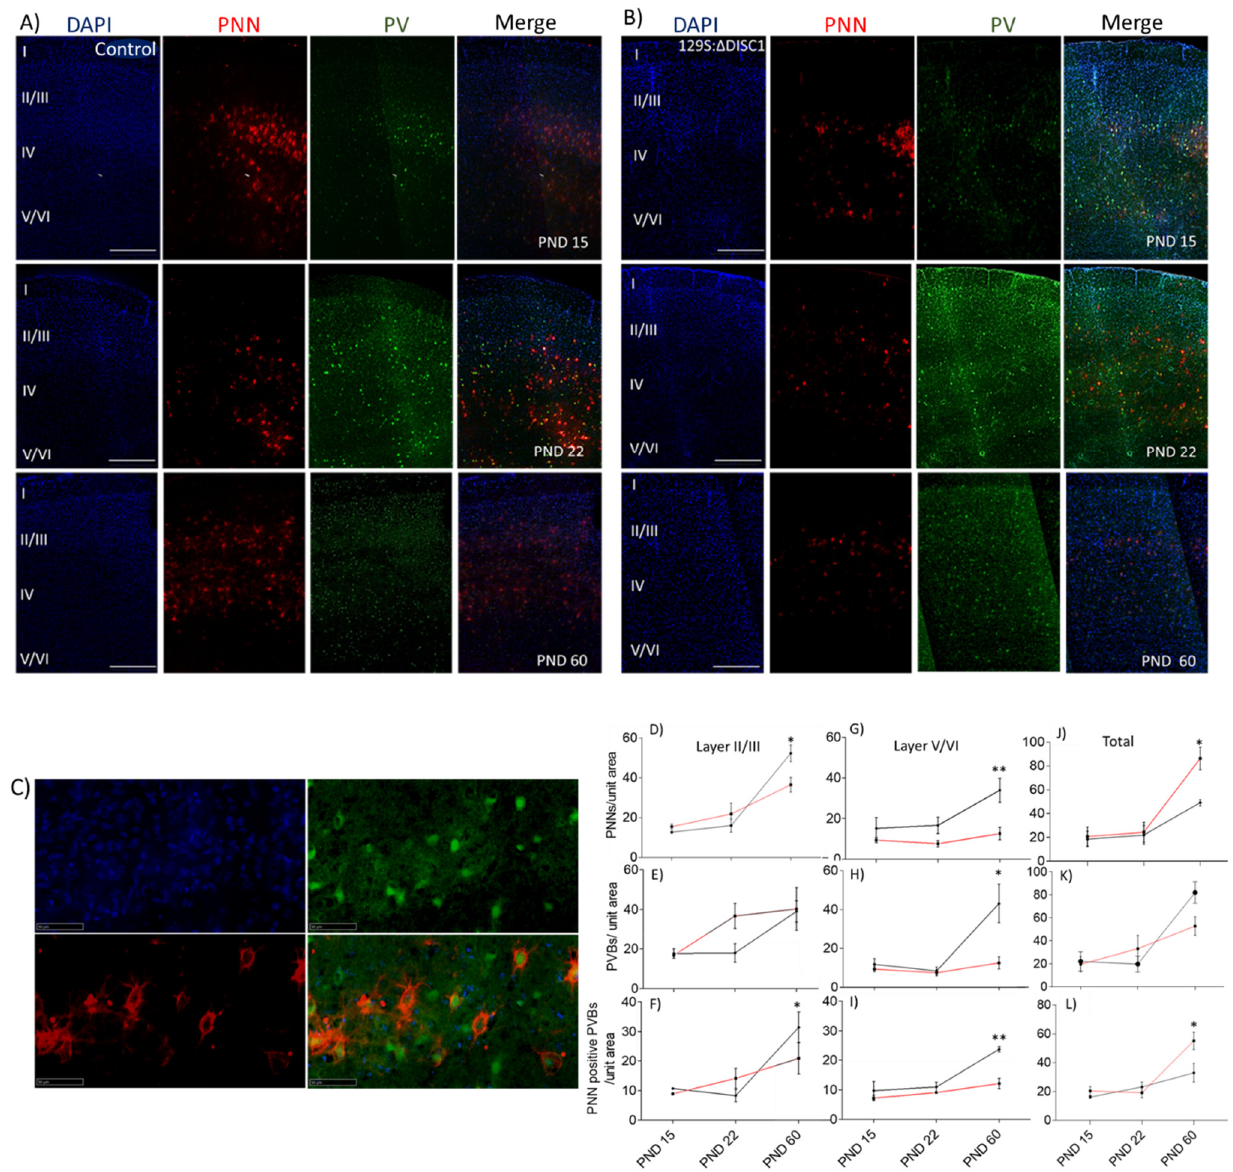
Figure 1. Representative immunofluorescent images and quantification . ( A , B ) control and DISC1 mutation : ∆ DISC1 age wise representation from postnatal day (PND) 15, 22, and 60, respectively; ( C ) high magnification image showing colocalization of PNN (red)/PV (green) /DAPI (blue). Roman numerals I–VI indicate cortical layers 1–6, respectively; ( D – I ) quantitative analysis of PNN, PVs and colocalization of the two in layers II-VI. ( J – L ) Total PNNs, PVBs and colocalization in PFC layers Black and red lines indicate Control and DISC1 mutation animals, respectively. The data are represented as a scatter line plot showing mean ± s.e.m. where * p ≤ 0.05, ** p ≤ 0.01, by one way-ANOVA.